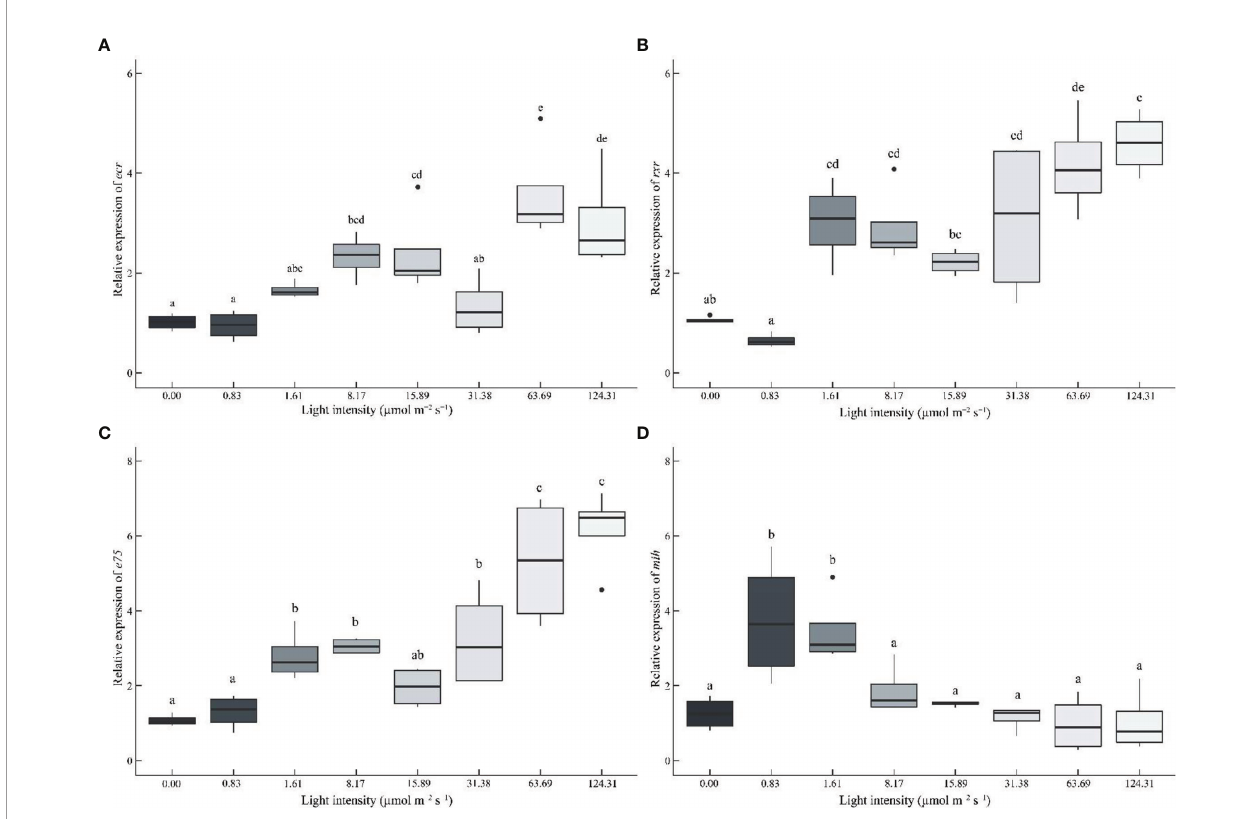
FIGURE 7 | Effect of different light intensities on the ecdysone receptor ( ecr ) (A) , retinoid X receptor ( rxr ) (B) , nuclear receptor E75 ( e75 ) (C) , and molt-inhibiting hormone ( mih ) (D) genes in the eyestalk of juvenile Portunus trituberculatus . Data (n = 4) with different letters signi fi cantly differ ( P < 0.05) among